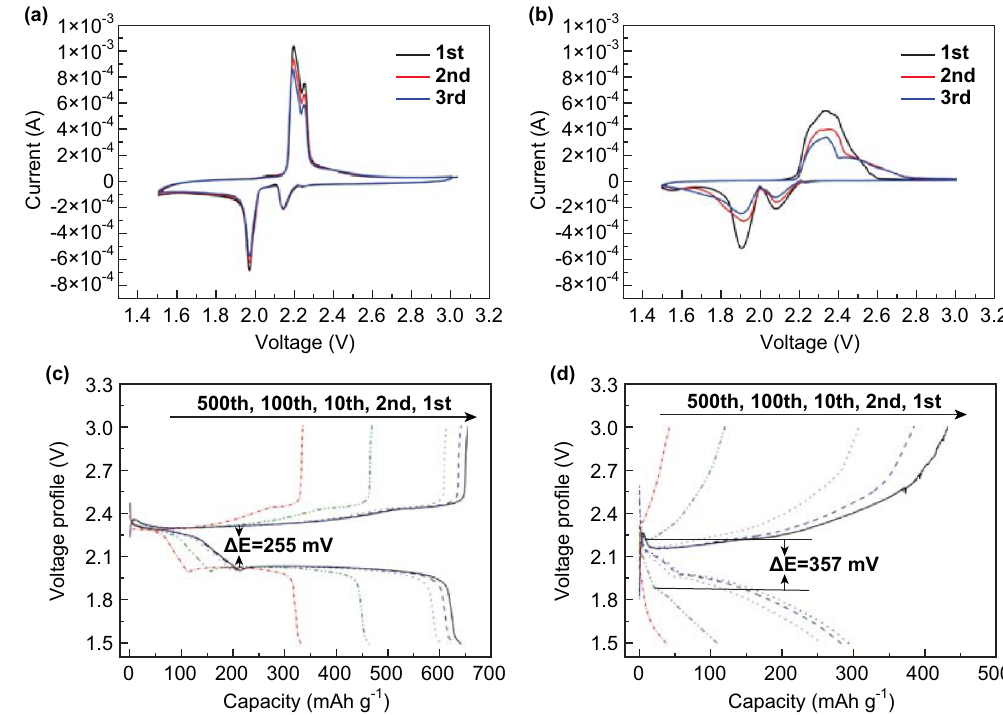
Fig. 5 CV curves of the first three cycles for Li–Se batteries a with and b without N,S-G interlayer at a scan rate of 0.1 mV s - 1 . Galvanostatic charge/discharge voltage profiles of Li–Se batteries c with and d without N,S-G interlayer at 1 C between 1.5 and 3.0 V